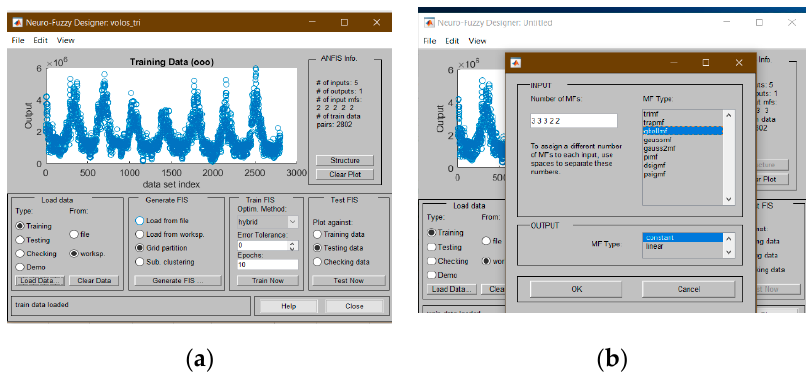
Figure 3. Screenshots regarding ( a ) the training dataset configuration, ( b ) the number and type of MF configuration.